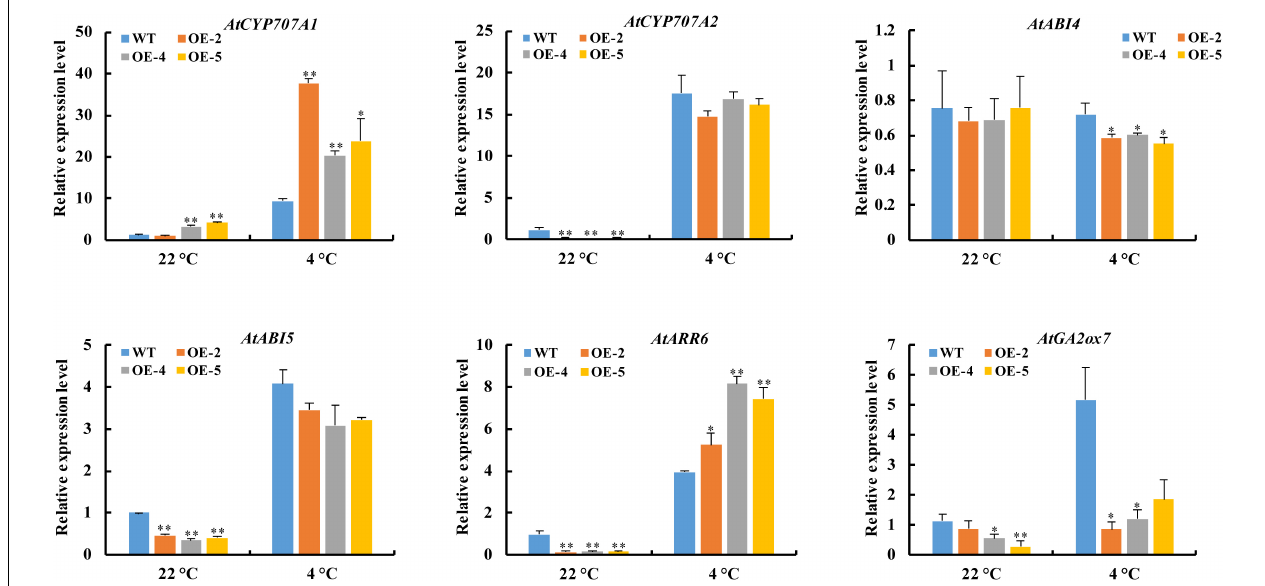
FIGURE 8 | Expression pattern of ABA/GA/CTK pathway-related genes regulated by RcGPX4 . The seeds of WT and transgenic lines imbibed for 1 day at 22 ◦ C and 8 days at 4 ◦ C were harvested for RNA extraction and qRT-PCR analysis. Data represent the mean ± SD of three independent biological replicates. Asterisks indicate a significant difference between wild type and overexpressed lines ( ∗ P < 0.05, ∗∗ P < 0.01, student’s t -test). ABA, abscisic acid ; GA, gibberellin acid; CTK,